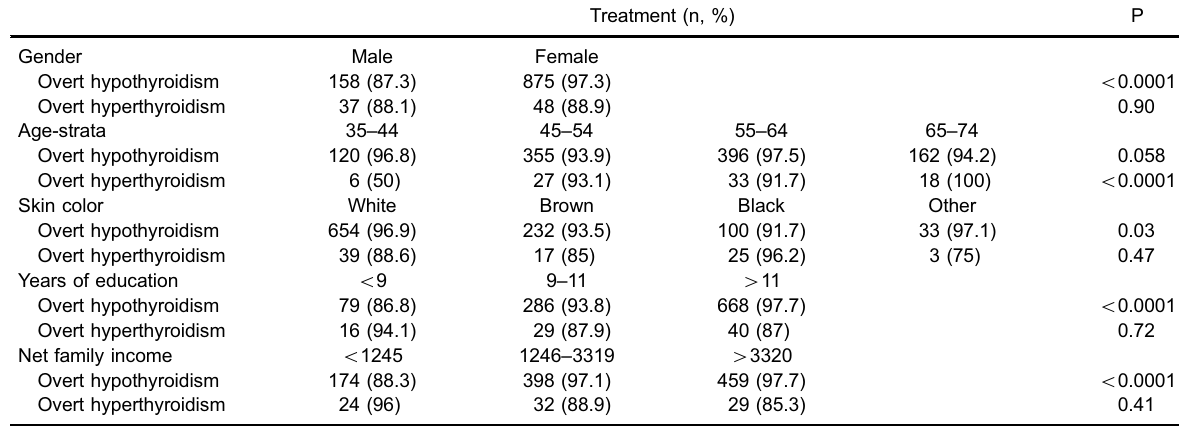
Table 3. Treatment of clinical hypothyroidism and hyperthyroidism according to sociodemographic characteristics.